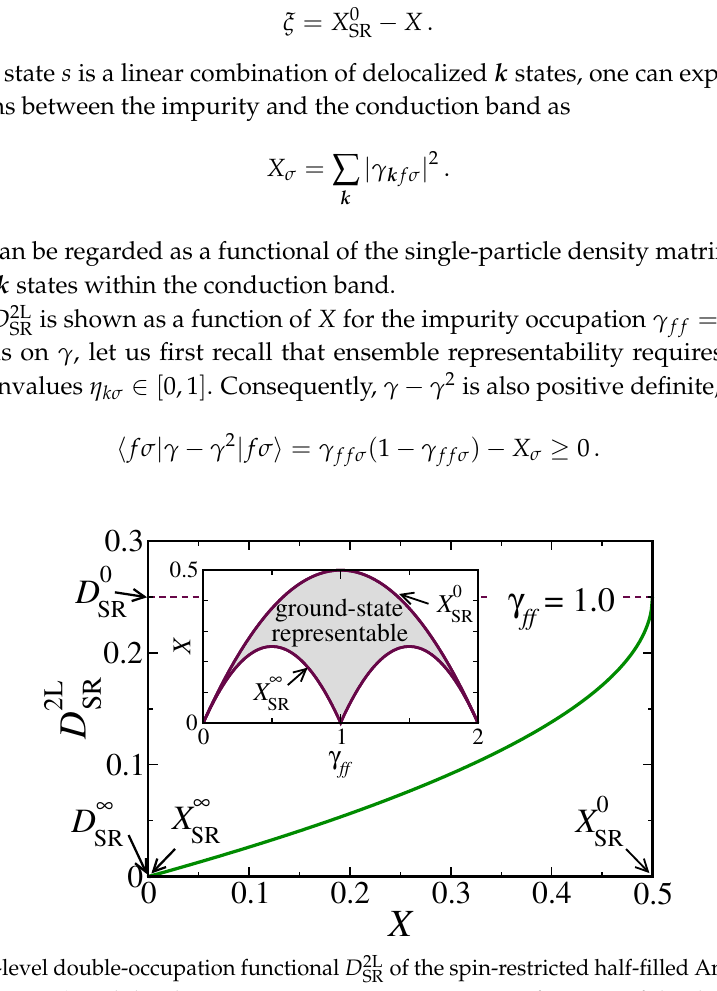
Figure 1. Two-level double-occupation functional D 2L of the spin-restricted half-filled Anderson model SR = γ ( γ and N = 2) with local impurity occupation γ f f = 1 as a function of the degree of charge ↑ ↓ fluctuations X . The values D ∞ and X ∞ ( D 0 and X 0 ) refer to the strongly correlated (uncorrelated) SR SR SR SR limit. The inset shows the corresponding domain of ground-state representability of γ (grey area) in terms of γ f f and X . Adapted with permission from Reference [71]. c (cid:13) American Physical